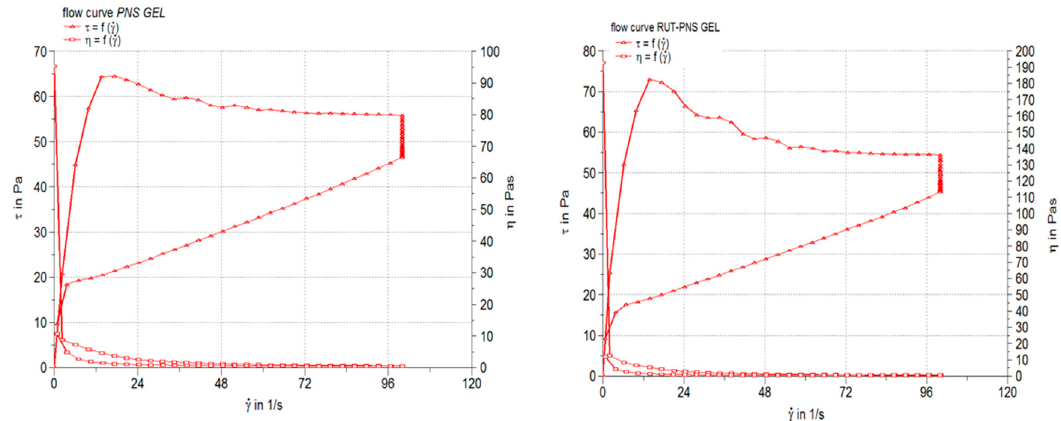
Figure 3. Rheograms and viscosity profiles of the proniosomal gels: control gel ( left ) and rutin-loaded gel ( right ). Table 2. Proniosomal gels characteristics: viscosity, thixotropy, penetration values and pH. Gel Code